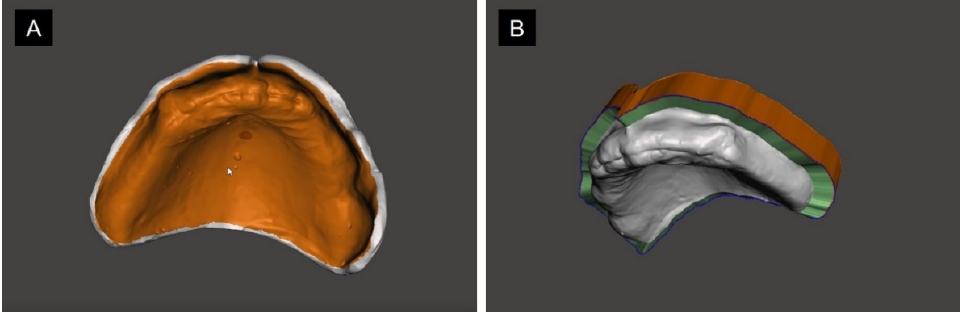
Figure 3. ( A ) Selecting the intaglio surface of the denture. ( B ) Producing a digital edentulous model using the “flip” function.